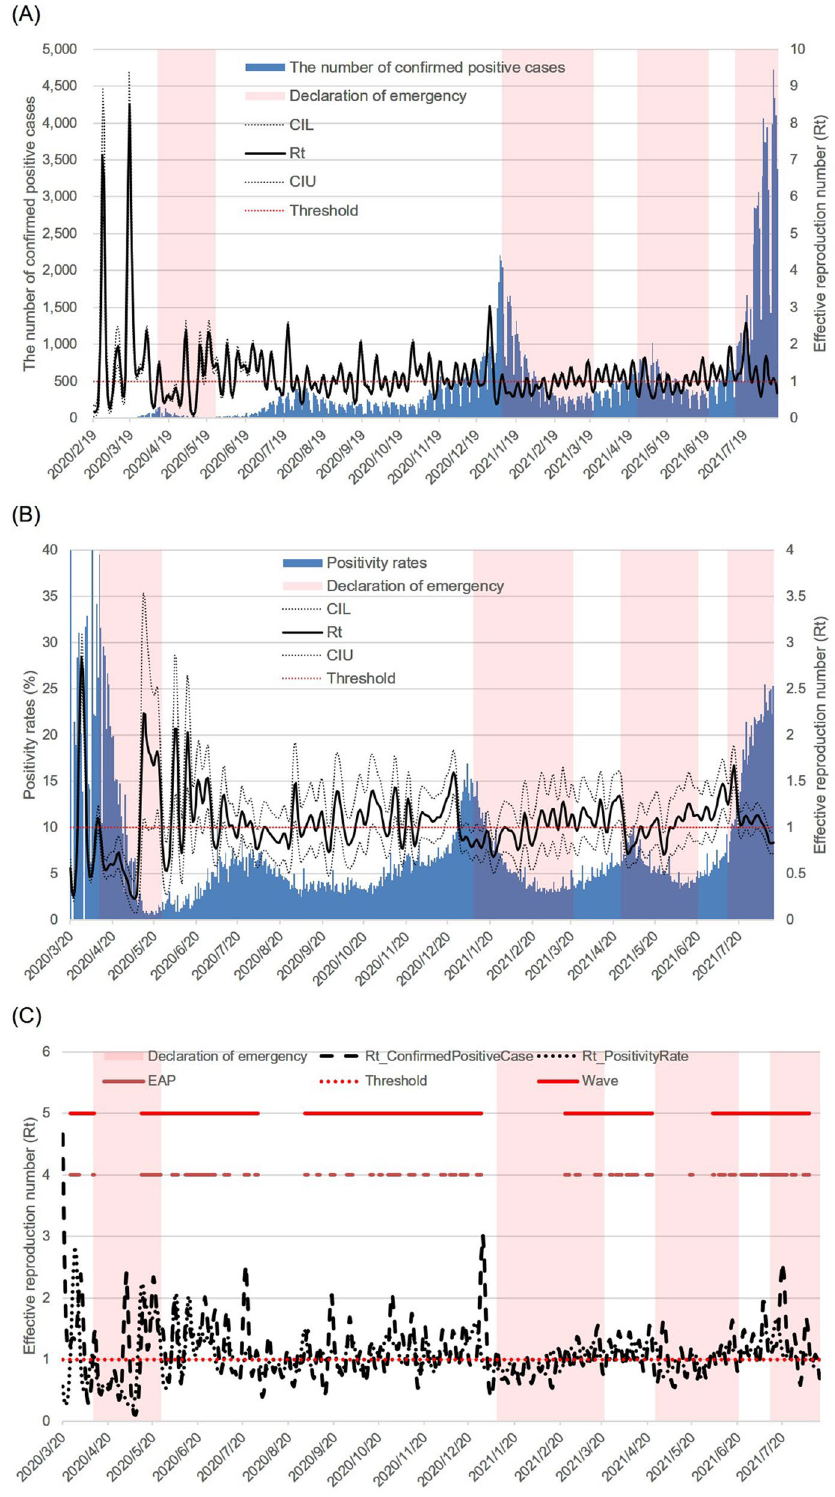
Figure 3. Two effective reproduction numbers, Epidemic Acceleration Period and waves. The estimated effective reproduction number ( R t ) and epidemic curve are shown in ( A , B ). In ( A ), the number of confirmed positive cases (blue bar), the R t (black line), the lower 95% credible interval limit of the R t (95% CIL) (black dotted line), the upper 95% credible interval limit of the R t (95% CIU) (black dotted line), the threshold for both the R t (1.0) (red dotted line), and the periods of emergency declaration (pink dotted line) are shown. The only difference between ( A and B ) is that the blue bar indicates the positivity rate. In ( C ), the R t estimated by data on the number of confirmed positive cases (black dashed line), the R t estimated by data on positivity rates (black dotted line), epidemic acceleration period (EAP) (orange line), wave (red line), the threshold for both R t (1.0) (red dotted line), and the periods of emergency declaration (pink dotted line) are